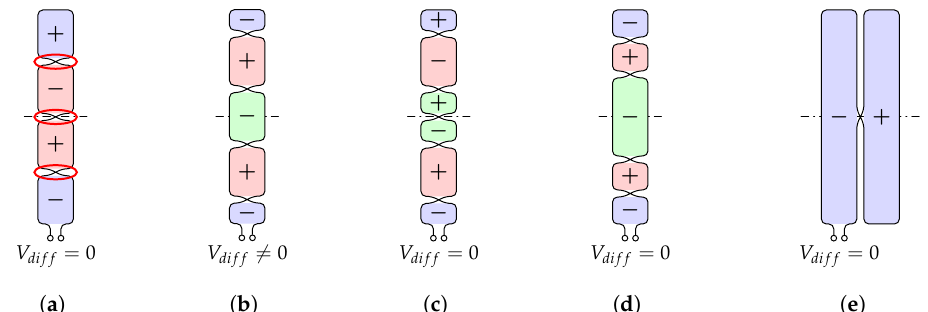
Figure 16. Compensation of areas where a sensor coil can be symmetrically stimulated by a foreign object (red markings)—the signs symbolize the orientation of the conductor loops, the colors the induced voltage ( a ) First level sensor coil ( b ) Principle of the second level sensor coil according to [26,27] ( c ) Consideration of the symmetry of the ground assembly coil for the second level sensor coil ( d ) Adjustment of the size of the conductor loops of the second level sensor coil ( e ) Conductor loops that completely cover the ground assembly coil in the considered spatial direction.